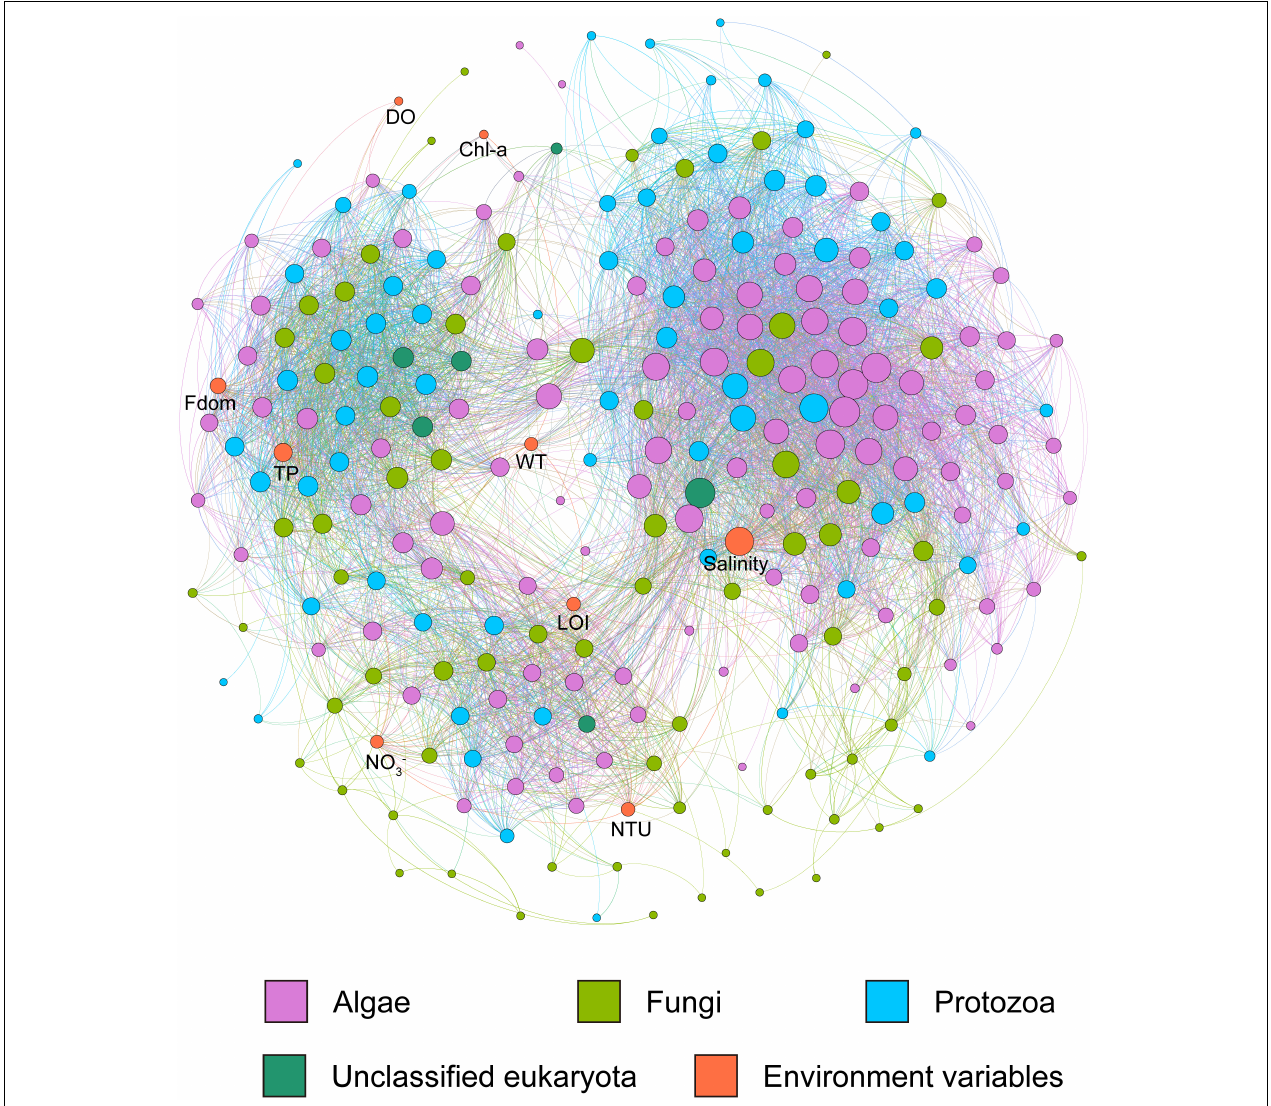
FIGURE 6 | Co-occurrence networks of microeukaryotic community and environmental variables in the lake system of the Inner Mongolia Plateau. The size of the circles shows the degree of the node, and the color of the circles shows the taxon of the node.